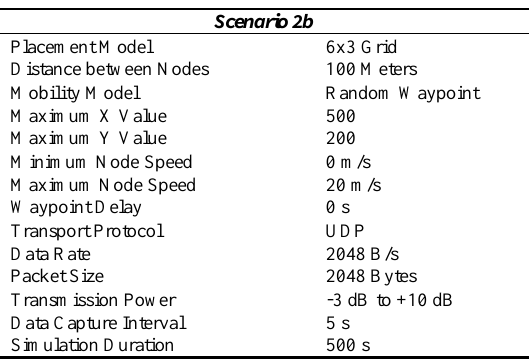
Table 14. Setting under Scenario 2b .